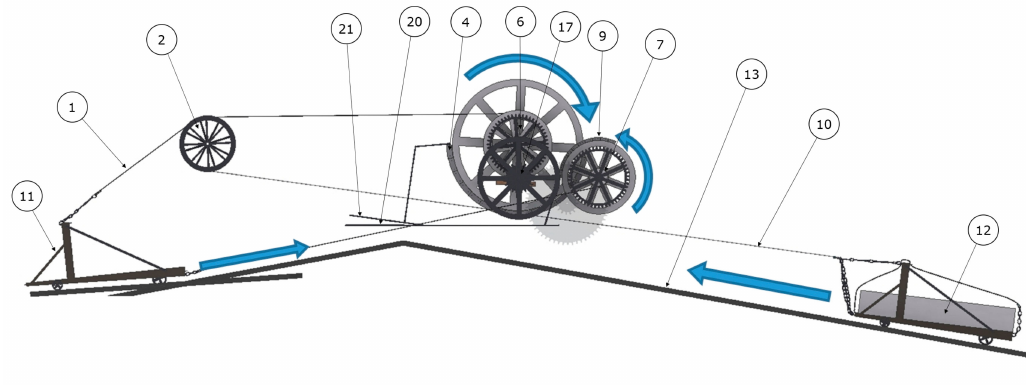
Figure 4. Sequence of movements in the ascent of the